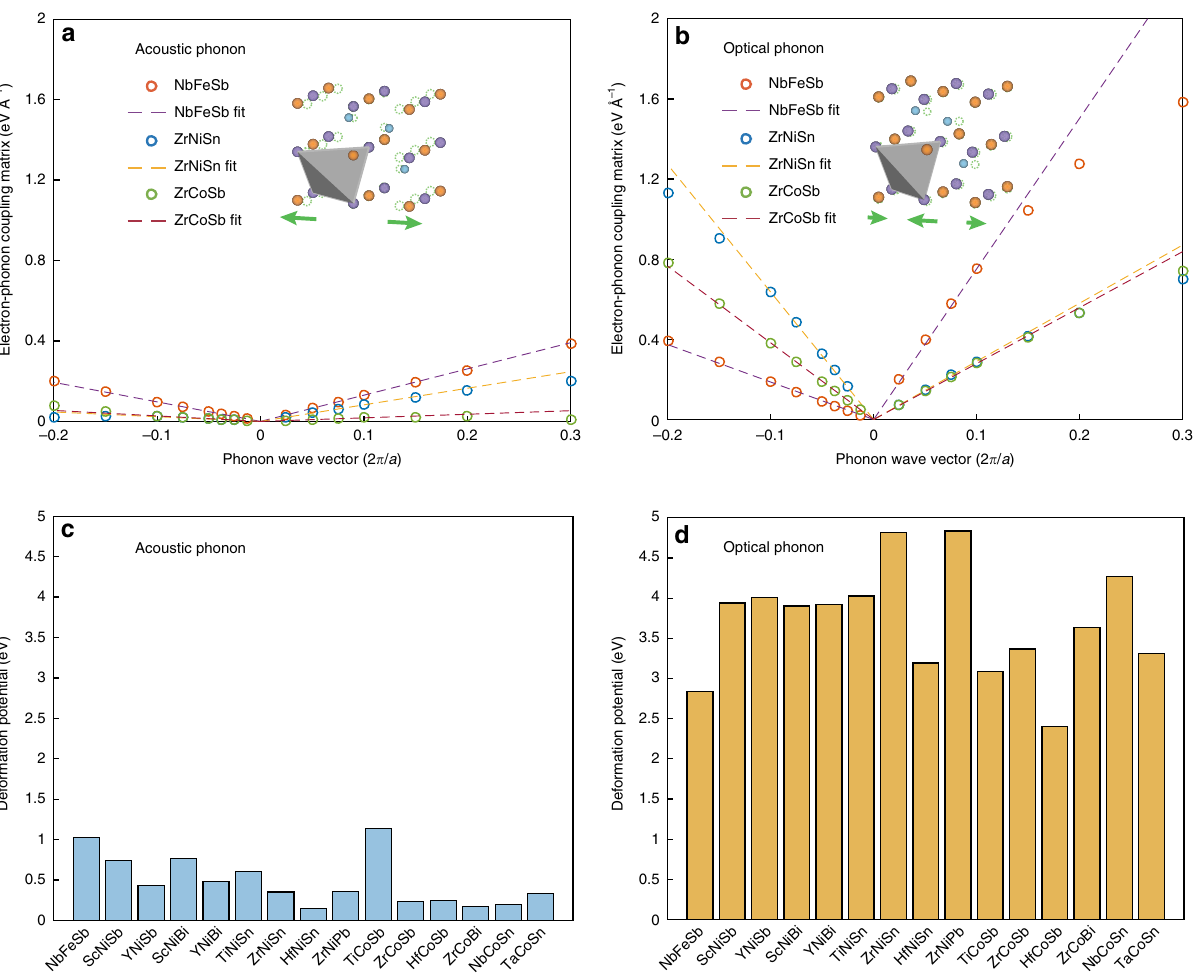
Fig. 1 Electron – phonon interaction and deformation potential. a , b Electron – phonon coupling matrix along high-symmetry lines. The coupling matrices are calculated along two different directions in the Brillouin zone for a longitudinal acoustic phonons and b optical phonons, respectively, with the initial ¼ ð 0 ; 0 ; 2 π = a Þ , where α is the lattice constant) and the fi nal electron in the same band (intra-band electron state located at the conduction band edge ( k X coupling). The insets in a and b illustrate the lattice distortions corresponding to acoustic and optical phonons. c , d Averaged deformation potential for acoustic and optical phonons. The deformation potentials are extracted as the slopes from a , b , for the two different directions (one is parallel with k X while the other is perpendicular), de fi ned as Ξ k and Ξ ? . The deformation potential generally depends on the directional angle of the phonon state, but for simplicity we calculate averaged deformation potential de fi ned as Ξ ¼ Ξ 1 = 3 k Ξ 2 = 3